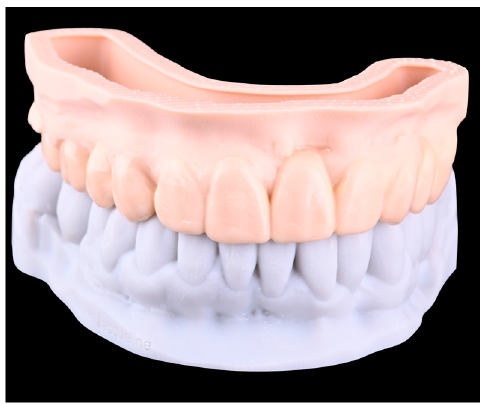
Figure 4. Printed diagnostic wax-up.